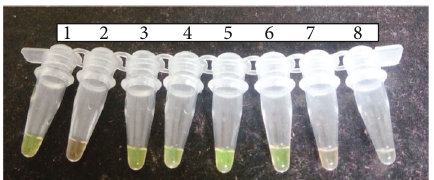
Figure 2: LAMP fl orescence dye detection (open tubes). Tube no. 1: W. bancrofti DNA-positive control; 2: negative control; 3, 4, 5, and 6: positive specimens; 7 and 8: negative specimens. Green color indicates that W uchereria bancrofti DNA was present and was ampli fi ed (positive). Orange color means that there was no W. bancrofti DNA and hence no ampli fi cation that took place (negative).